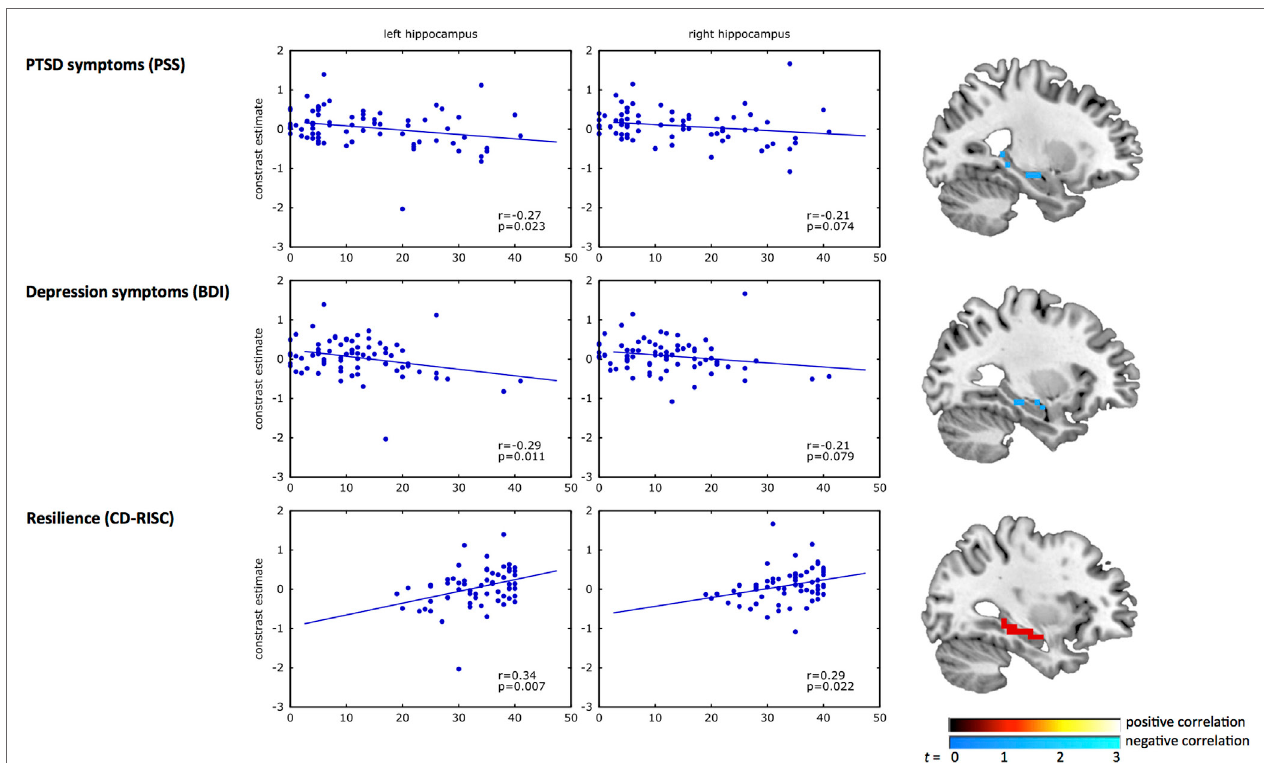
FigUre 2 | correlation analyses of hippocampal activation with psychiatric outcome and resilience . The scatterplots show the correlation of response inhibition-related BOLD activation in the left and right hippocampus with PTSD symptoms (top panel), depression symptoms (middle panel), and resilience (bottom panel). In each plot, the blue dots represent the inhibition-related activation of each participant ( y -axis) plotted against the clinical measure for PTSD symptoms [Modified PTSD Symptom Scale (PSS) (40)], depression symptoms [Beck Depression Inventory (BDI) (41)], and resilience [Connor–Davidson Resilience scale (CD-RISC) (42)] on the x -axis. The brain images on the right show the uncorrected ( p < 0.01) activation within the structural hippocampal ROI, presented for illustrative purposes only. A negative correlation was observed between inhibition-related hippocampal activation and PSS and BDI, whereas a positive correlation with CD-RISC was